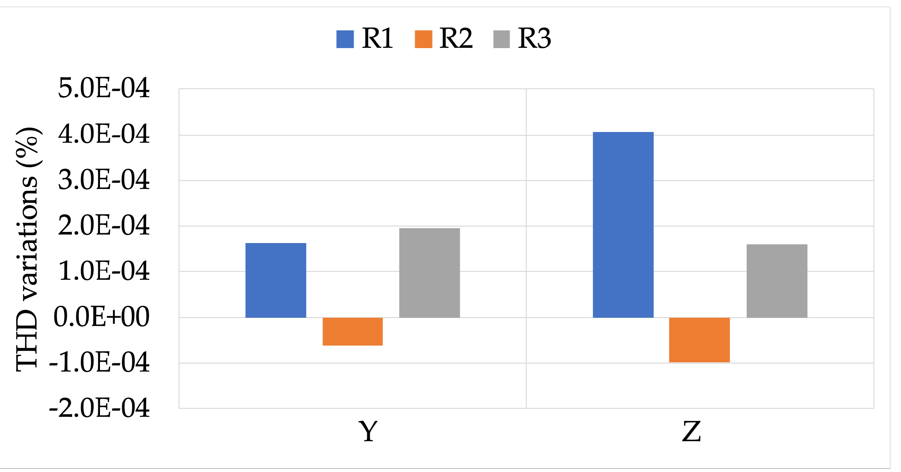
Figure 8. THD variations, compared to position L, obtained from measurements at the position M.